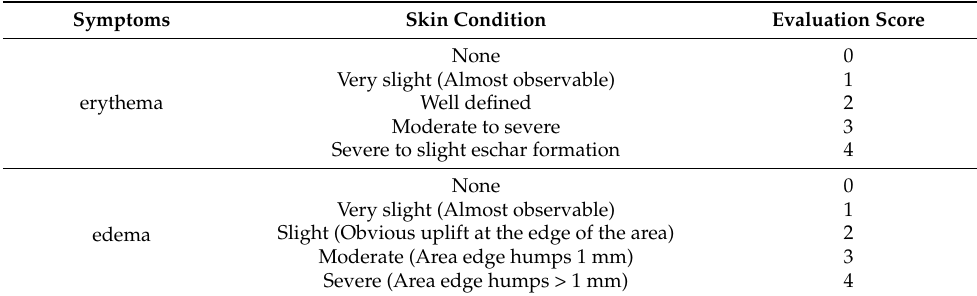
Table 7. Scoring criteria for skin